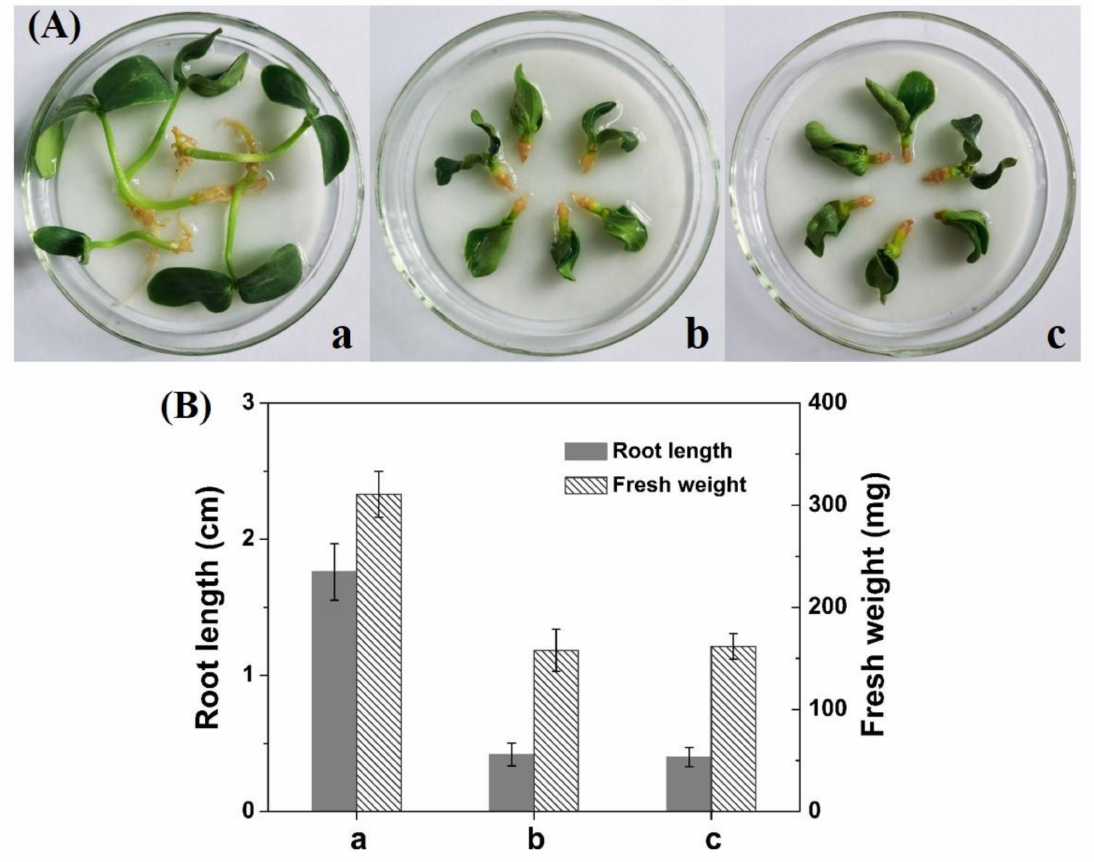
Figure 6. Bioactivity for target plant cucumber. ( A ) Photographs and ( B ) root height and fresh weight of cucumber for ( a ) control with deionized water, ( b ) free 2,4-D and ( c ) 2,4-D-loaded CMCS-DEACMS